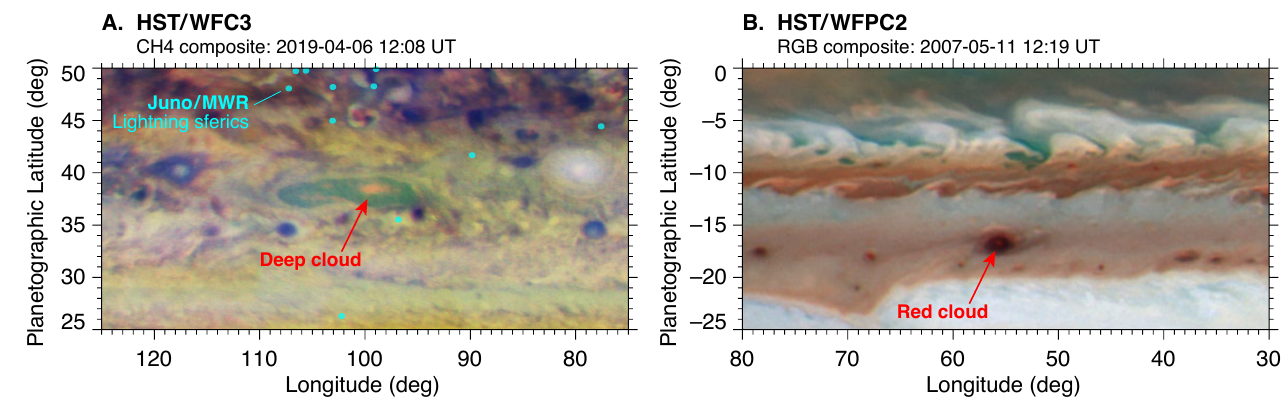
Figure 5. “Barges”—cyclonic vortices with smooth, well-defined edges [72]—often are dark in color with compact central clouds. These central clouds may be examples of deep water clouds in the absence of moist convection, although such clouds might precede or follow convective